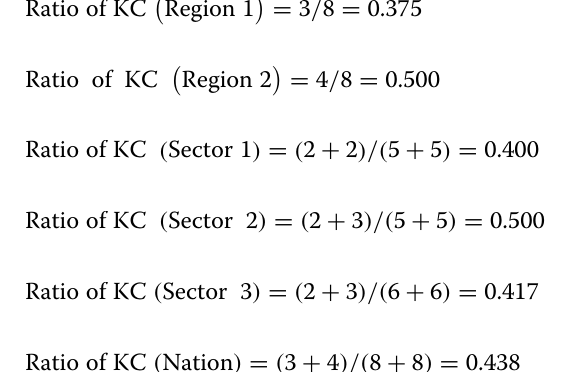
Table 1 An example of locations of aberrant KCs in an imaginary nation